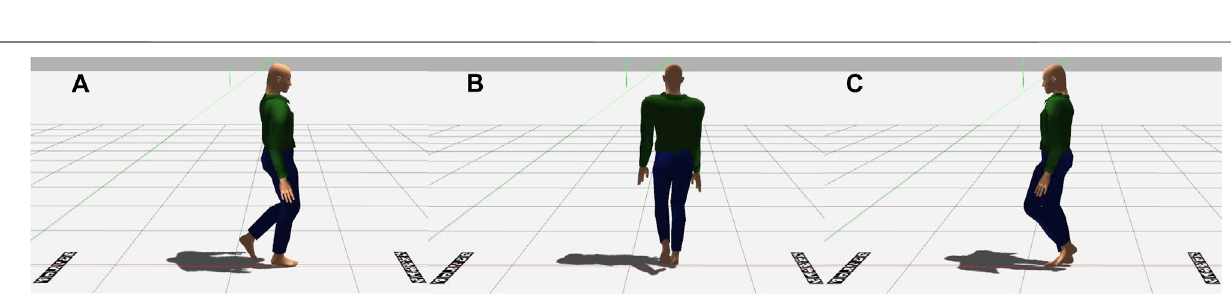
FIGURE 11 | The Actor turning back when reaching a target distance at 2.0 m.